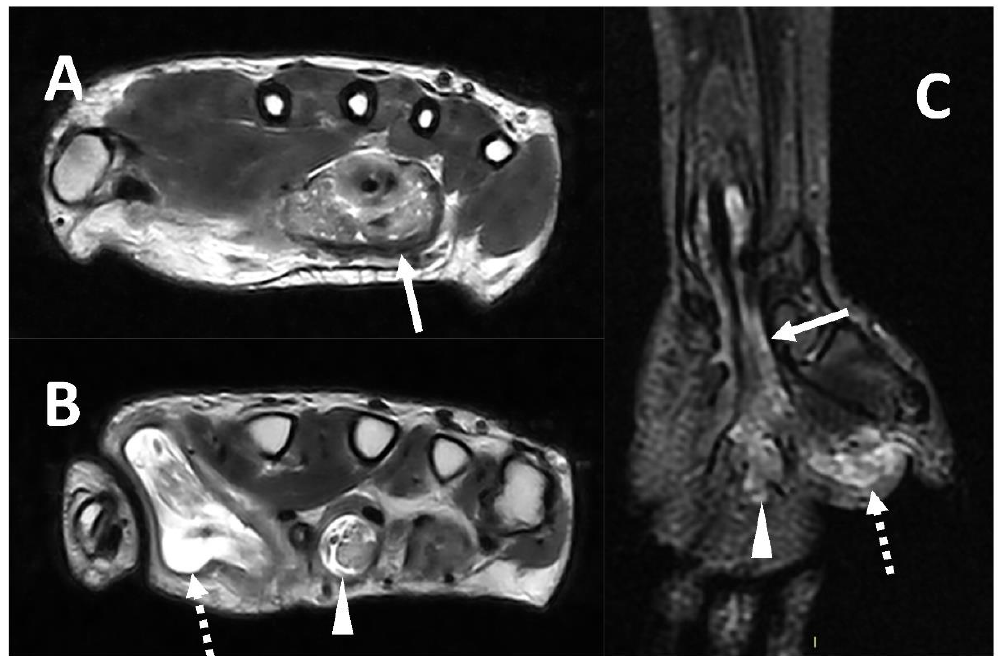
Figure 8. MRI (Panel A and B , T2w axial; Panel C , T2w coronal sequence) of a 39-year-old male complaining of progressively increasing swelling of the right wrist and hand shows a marked tenosynovitis involving the common flexor digitorum sheaths (arrows), as well as the flexor pollicis longus (dotted arrows) and the flexor of the third digit (arrowhead). Both synovial thickening and fluid collection can be detected. The final diagnosis is tenosynovitis related to mycobacterium tuberculosis.